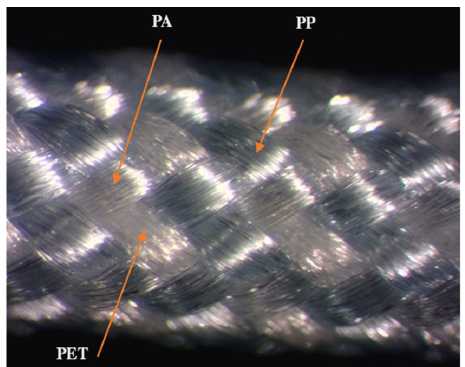
Figure 2. Microscope images of sutures ʹ surface texture (magnification, 25×).